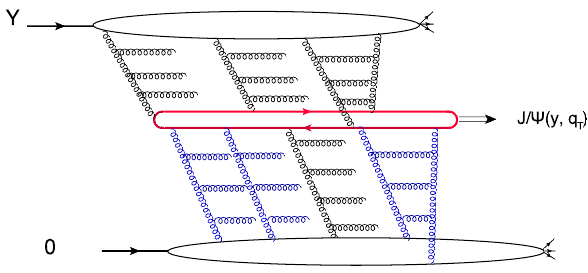
Fig. 9 Alternative mechanism of multiplicity enhancement. The lad- ders in this figure show the solution of the non-linear BK equation